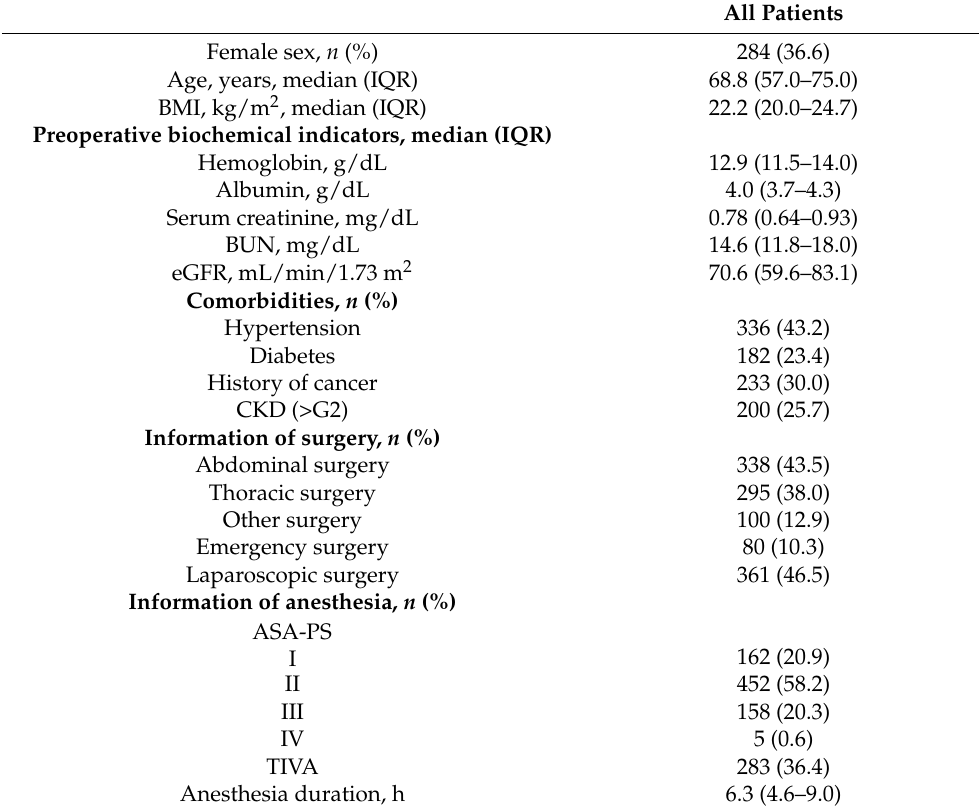
Table 1. Patient